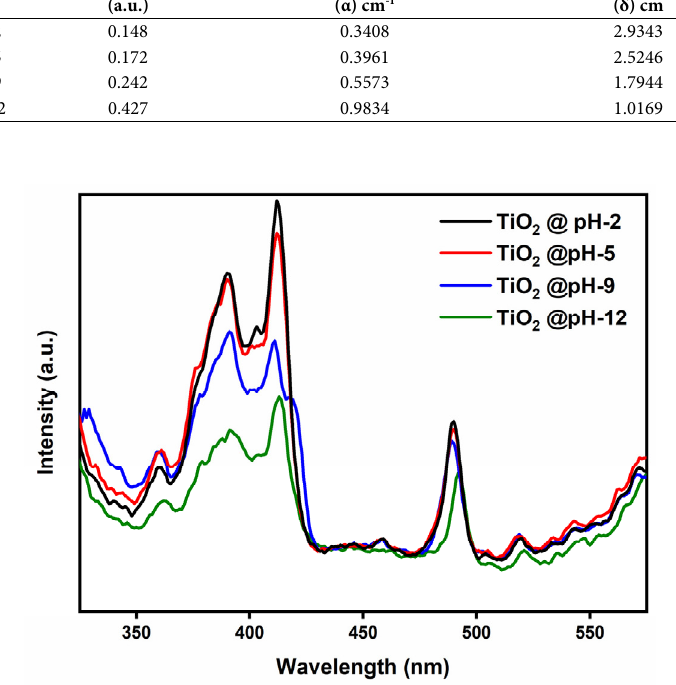
Fig. 7. Photoluminesescence Spectra of TiO